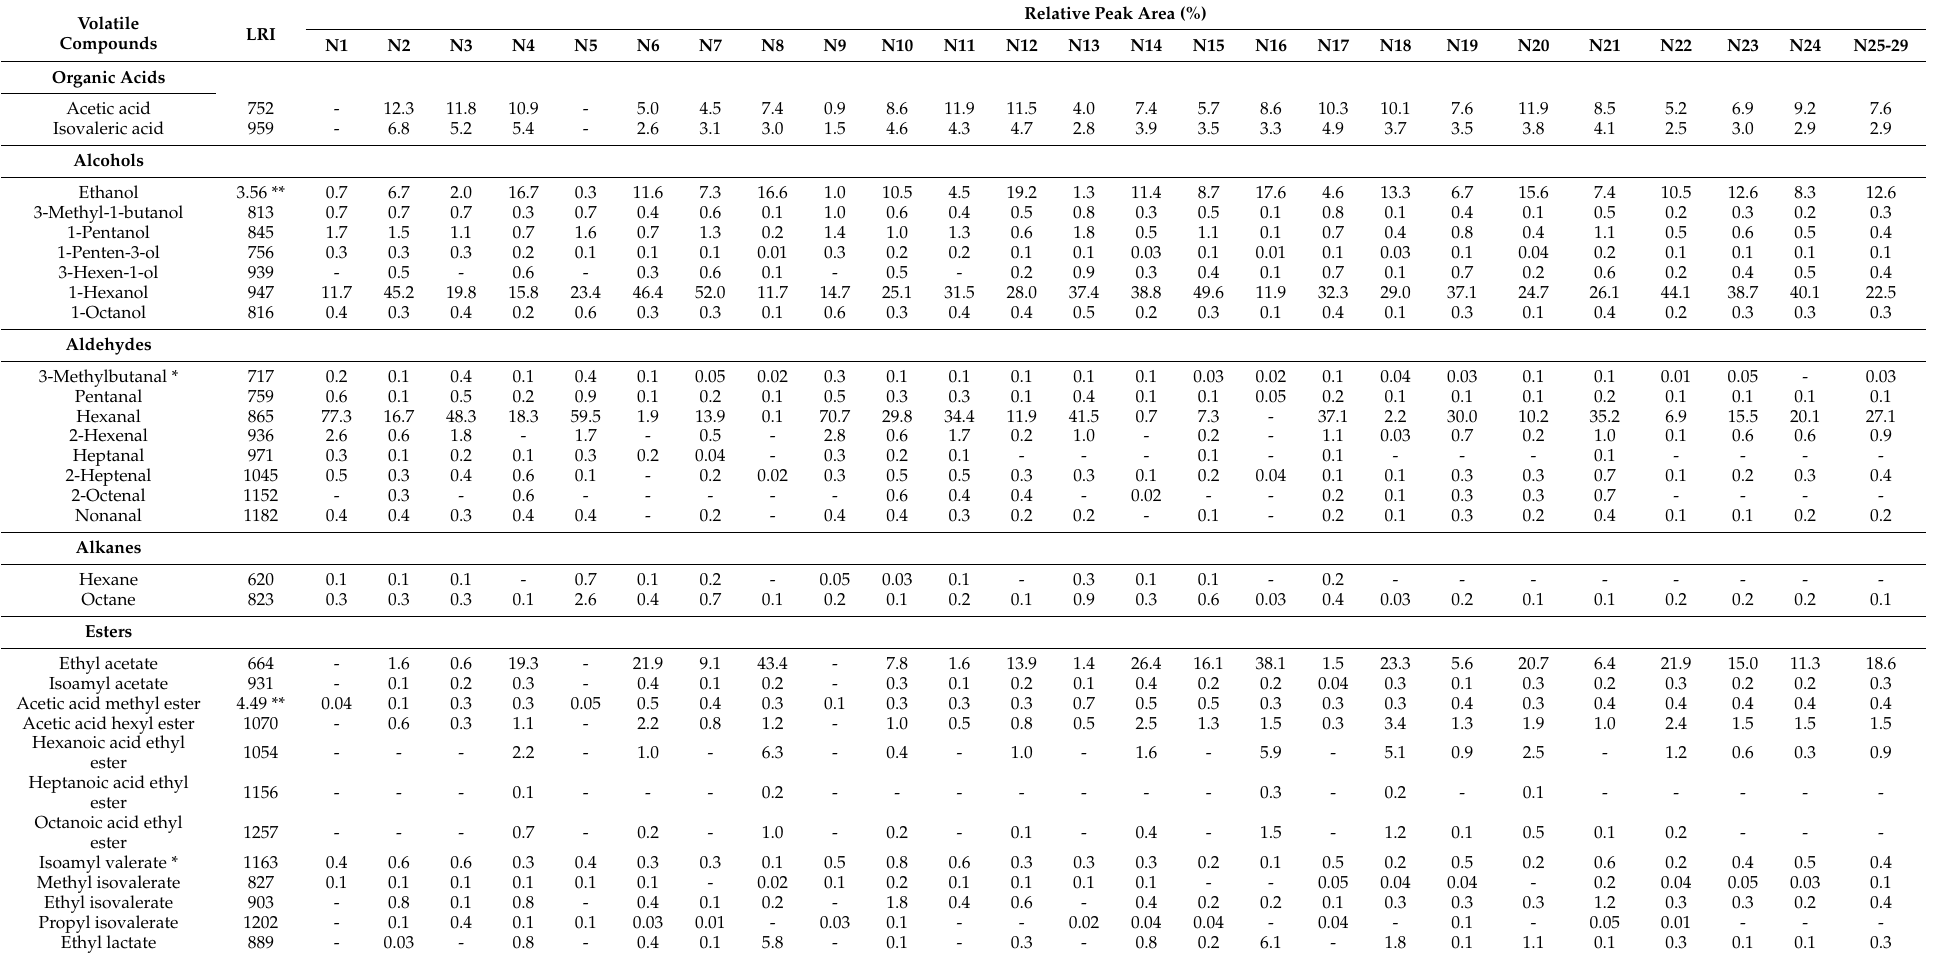
Table 2. Volatile compounds in faba bean protein concentrate as affected by time, temperature, dough yield, and inoculum ratio during fermentation by Weissella confusa A16. Refer to Table 1 for the fermentation parameters of each sample (N1–N24 and the mean of samples N25–29). Number of replicates N =